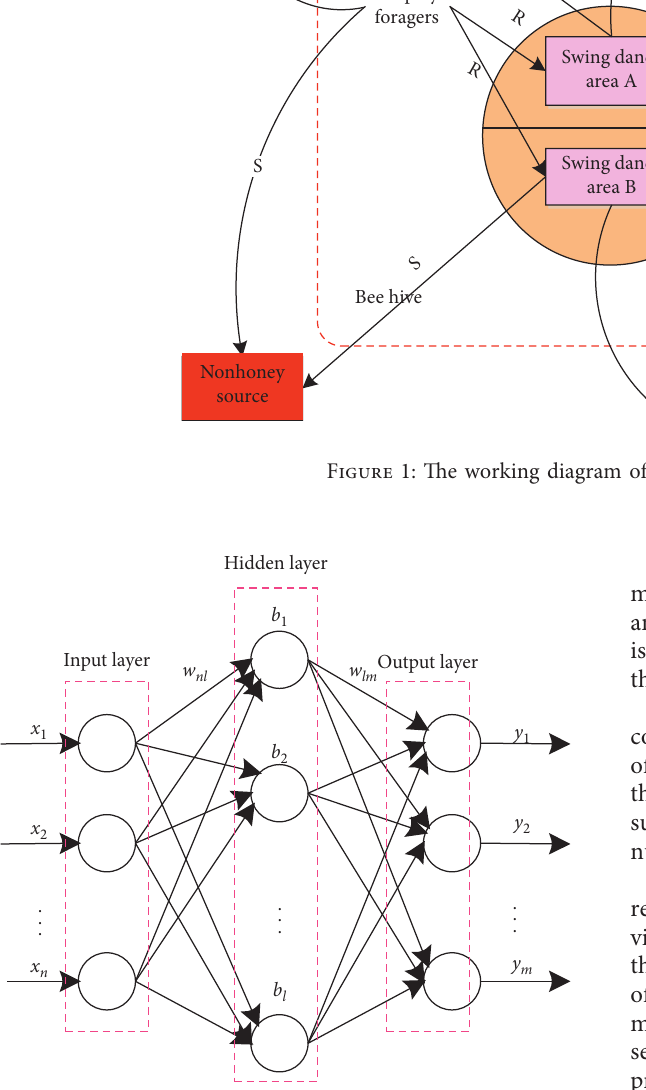
Figure 2: Structure diagram of extreme learning